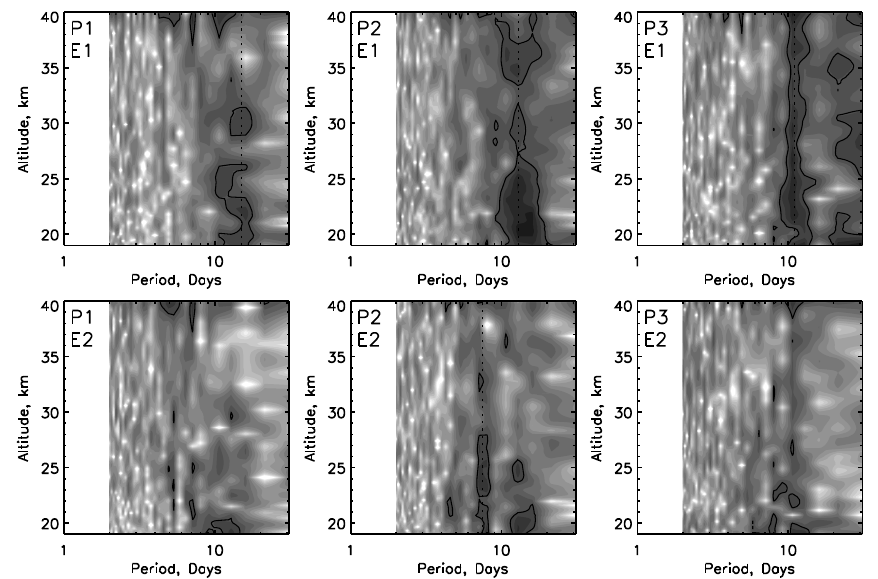
Fig. 6. Two-dimensional Fourier power during the three periods of interest (columns) at wavenumbers 1 and 2 (rows) from the wavenumber- period-power distribution divided by the background noise spectrum. The thick black contours show the 95% confidence levels. The colour code is same as in Fig. 5.